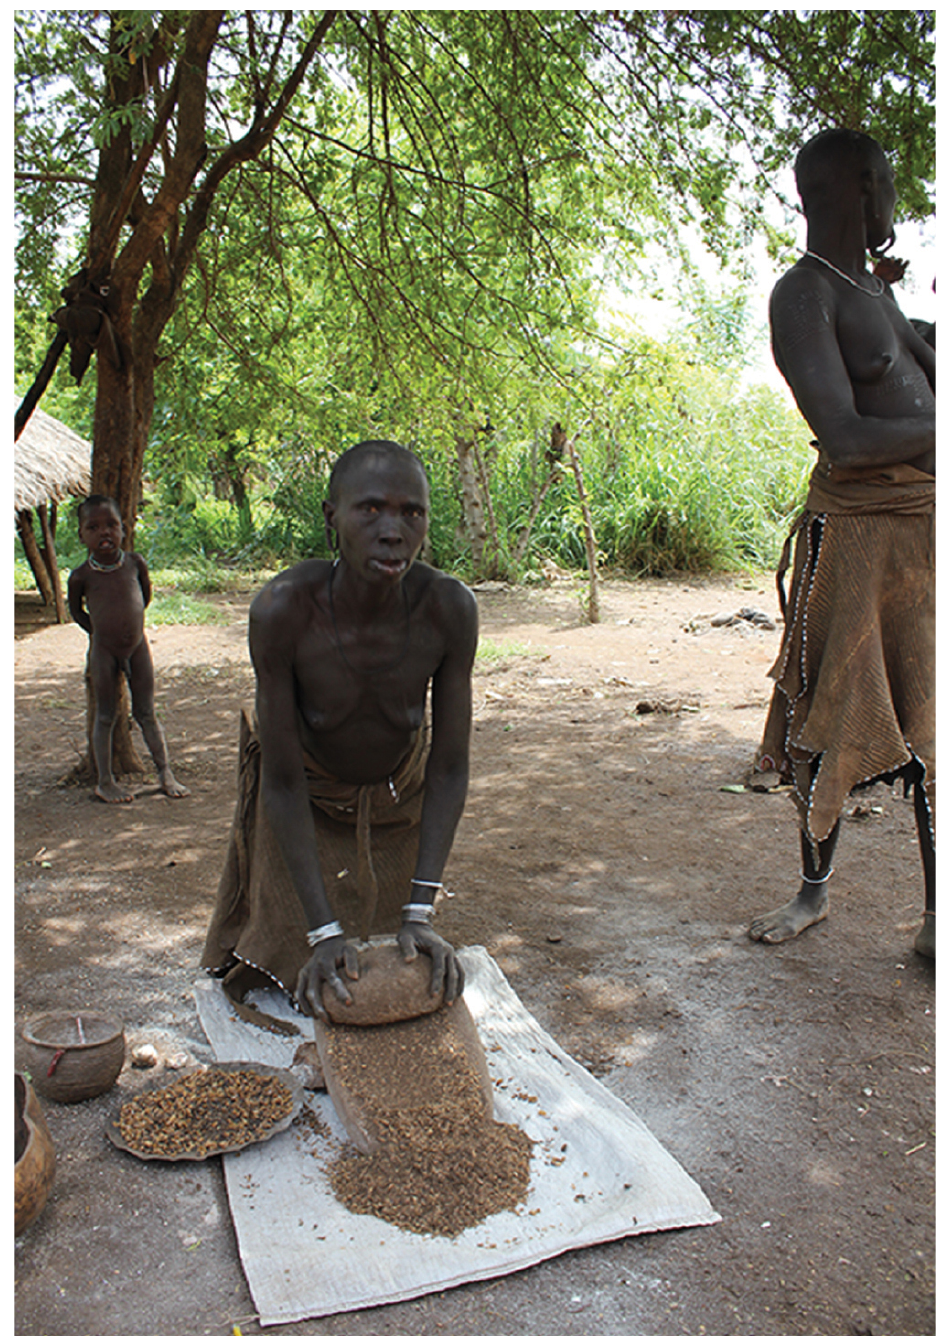
Figure 6. Woman crushing buna by using a handstone that has been pre-selected for this purpose and with a back and forth motion, rolling the handstone over the material to crush